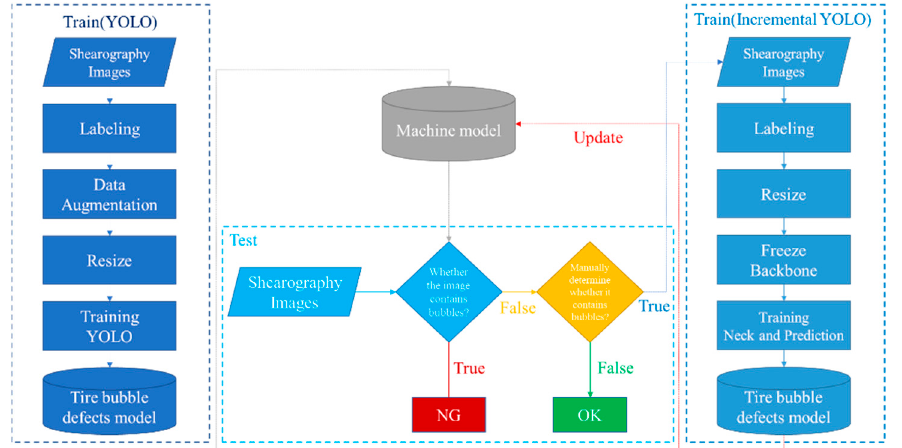
Figure 1. The bubble detection process.